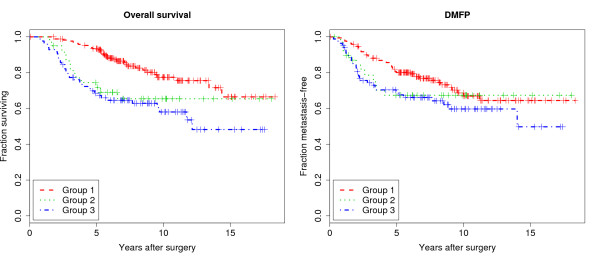
Kaplan-Meier curves for overall survival and DMFP for the three groups defined by SLC39A6/GATA3. The Kaplan-Meier survival curves (left) and DMFP curves (right) for each of the three groups defined by SLC39A6 and GATA3.